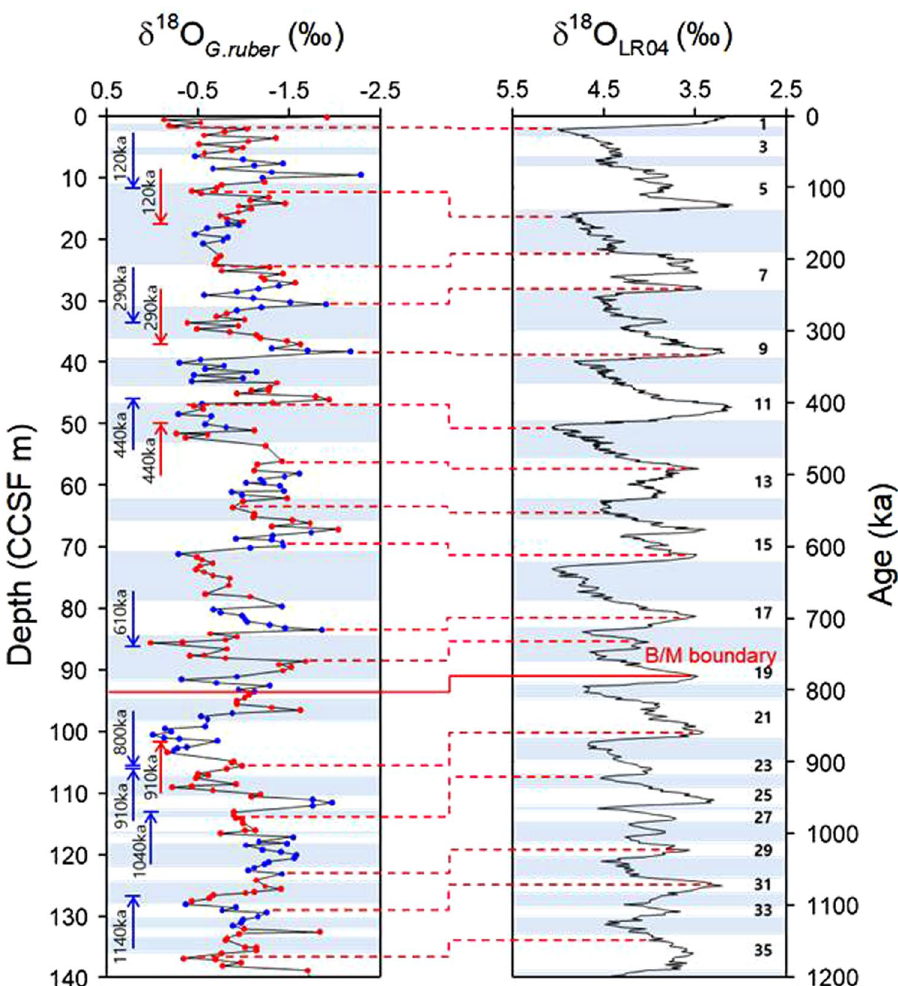
Figure 2. Age model of uppermost Unit I at Site U1456 reconstructed by δ 18 O values of planktonic foraminifera to correlate to LR04 stacks. The left figure depicts downcore variations in δ 18 O values of planktonic foraminifera ( G. ruber ) measured from Unit I at Site U1456 and the right figure shows LR04 stacks of benthic foraminiferal δ 18 O values 36 . The blue and red dots in the left figure are δ 18 O data from Holes U1456A and U1456C, respectively. The blue (Hole U1456A) and red (Hole U1456C) arrows represent the range of shipboard biostratigraphic datum 30 . The red solid line indicates the Brunhes-Matuyama (B/M) boundary (781 ka) 30 . The white interval represents interglacial periods characterized by low δ 18 O values, whereas the blue interval covers the glacial periods showing the high δ 18 O value. Detailed age reconstruction is explained in Supplementary Figure